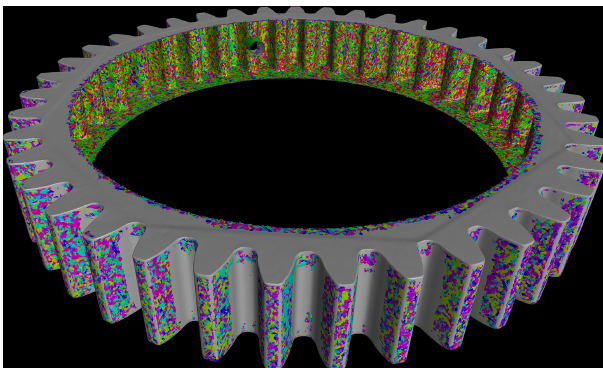
Figure 4. Examination of the geometry-altering mesh operations using a nominal–actual comparison and a Gaussian fit.